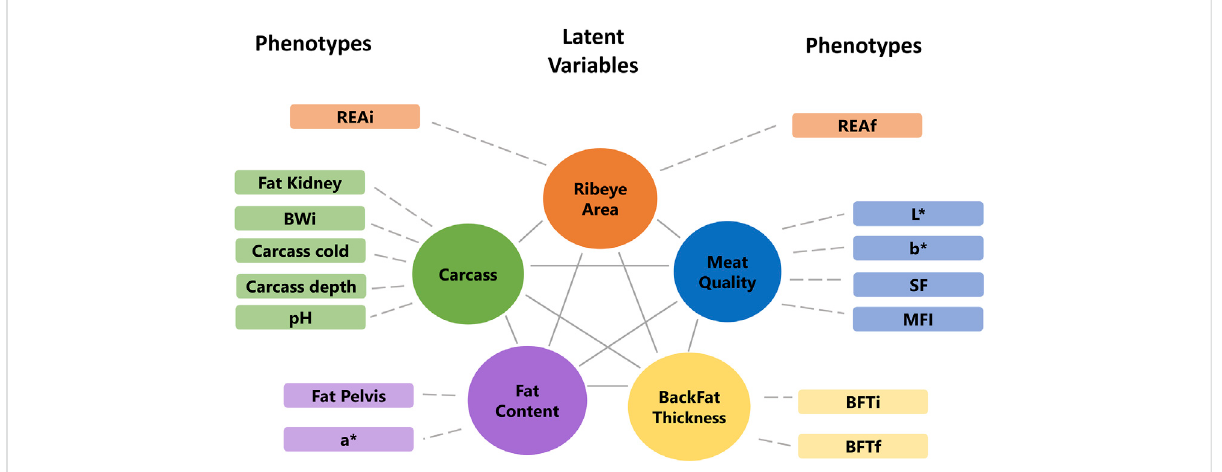
Final underlying latent structures of phenotypes generated by exploratory factor analysis. BWi: initial body weight on feedlot trial; REAi: initial ribeye area by ultrasonography; REAf: fi nal ribeye area on steak; BFTi: initial backfat thickness by ultrasonography; BFTf: fi nal backfat thickness by carcass; SF: shear-force; MFI: myo fi brillar fragmentation index; and L*, a*, b*: color parameters.